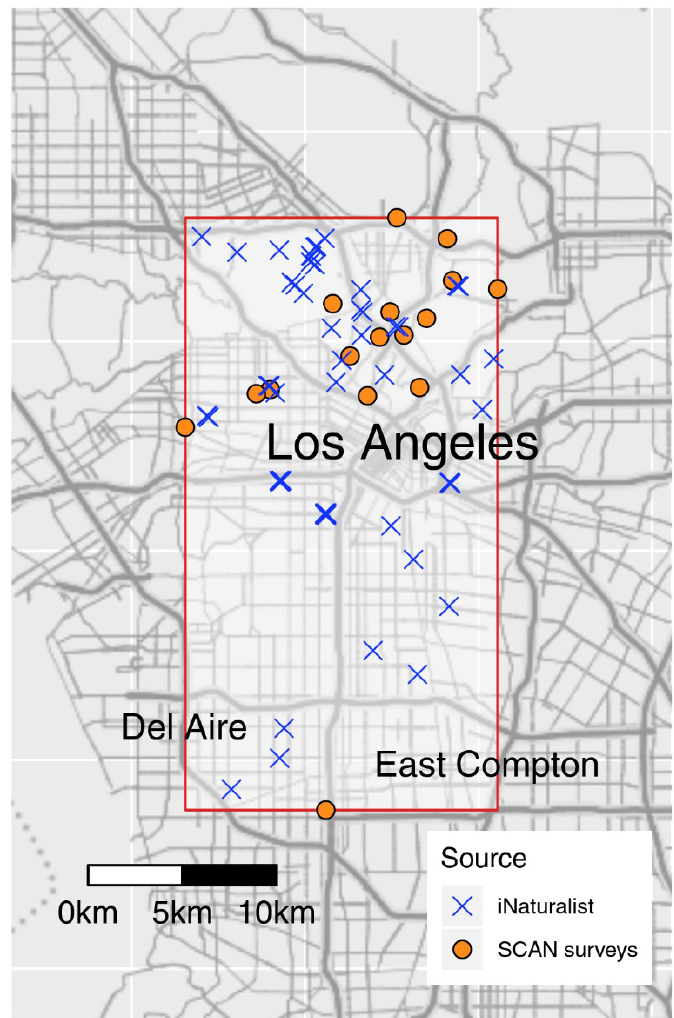
Figure 1. Sites included in this study. Orange circles indicate sites from the ButterflySCAN and BioSCAN approaches, while blue crosses show the sites of iNaturalist observations used in this work. The red rectangle defines the coordinate bounding box from which iNaturalist observations were sampled.